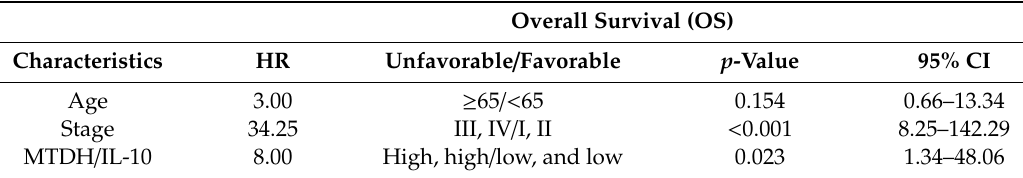
Table 3. Cox regression analysis for the influence of age, stage, and MTDH / IL-10 on overall survival in 107 ER-negative and / or PR-negative breast carcinoma patients.